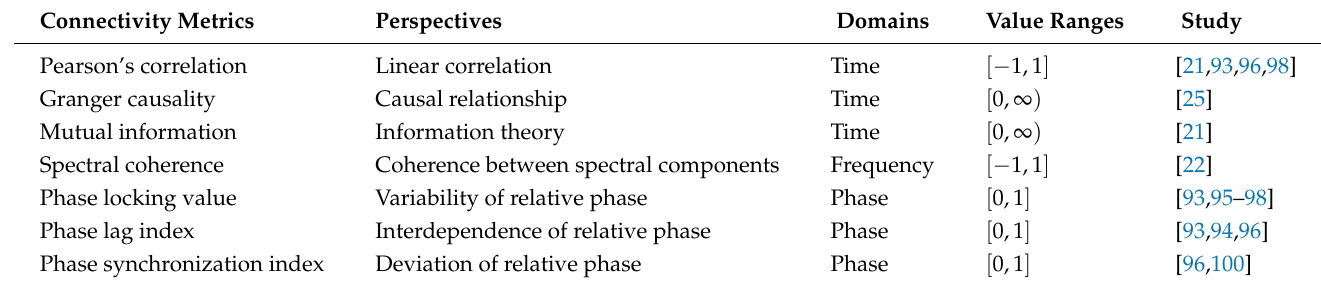
Table 3. Connectivity